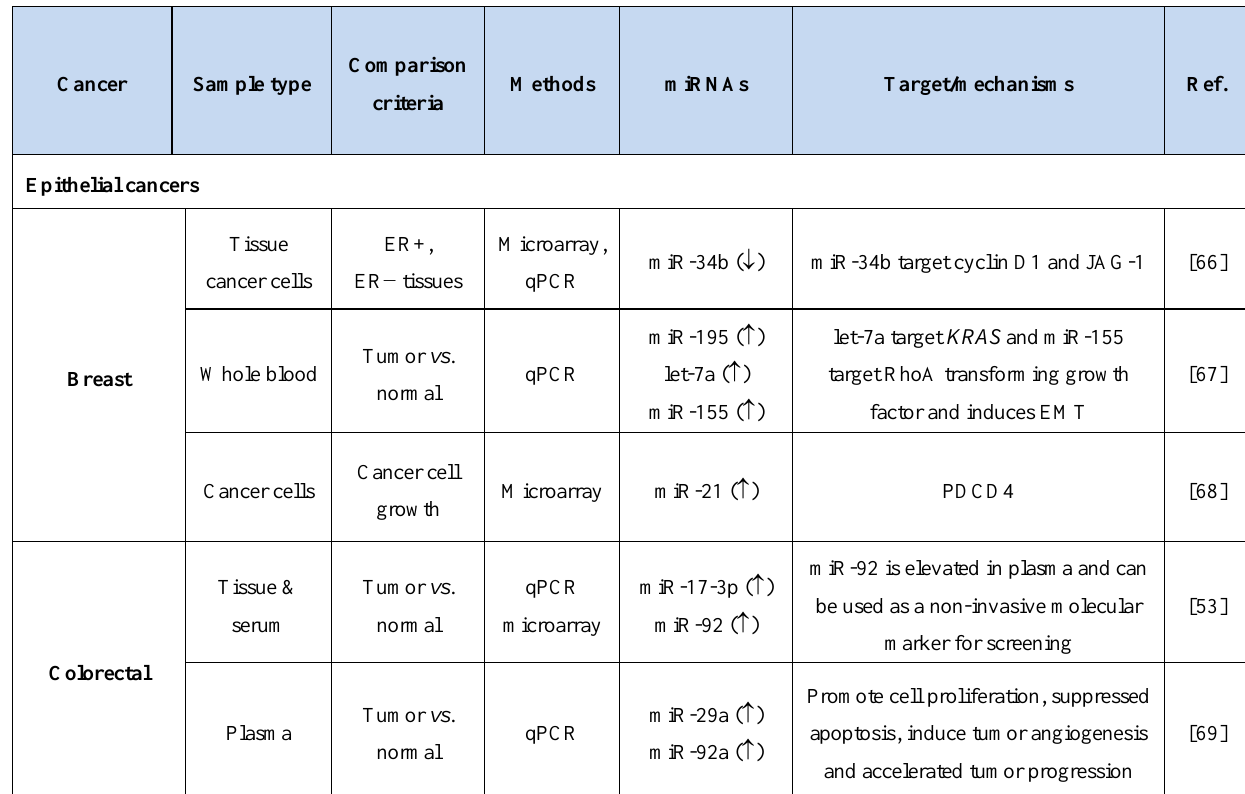
Table 1. miRNAs in various cancer types, their source and validated